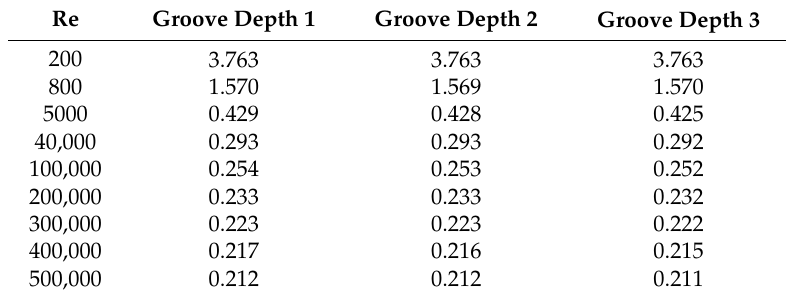
Table 3. Loss coe ffi cients under di ff erent groove depth.